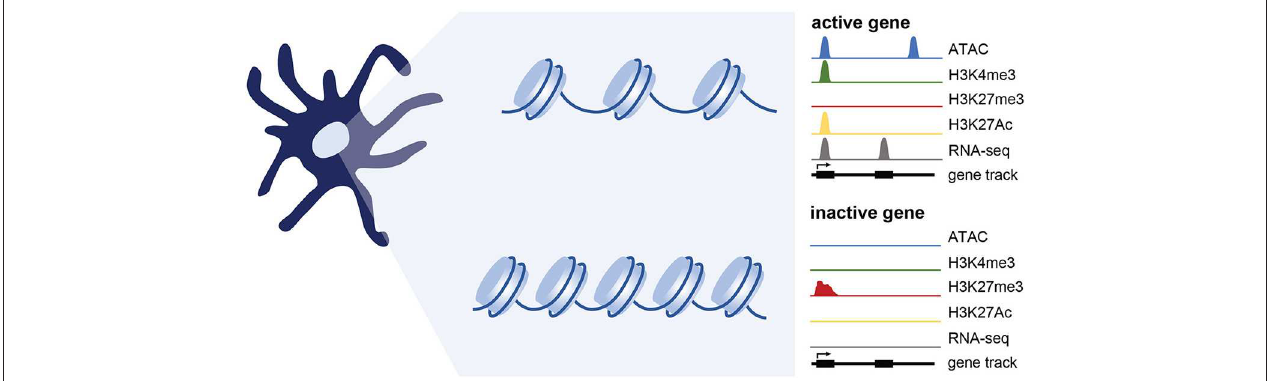
FIGURE 2 | Epigenetic changes associated with gene expression. Simplified representation of data profiles of ATAC-seq, ChIP-seq, and RNA-seq showing an active or inactive gene. Active genes are accessible (measured using ATAC-seq) and bear chromatin modifications associated with transcriptional activation such as H3K4me3 and H3K27Ac. Genes that are inactive are maintained in a repressed, less accessible state and are marked by histone modifications such as H3K27me3. While not extensively tested in DCs, genes poised for expression likely maintain accessibility, and may have a mix of activating and repressive